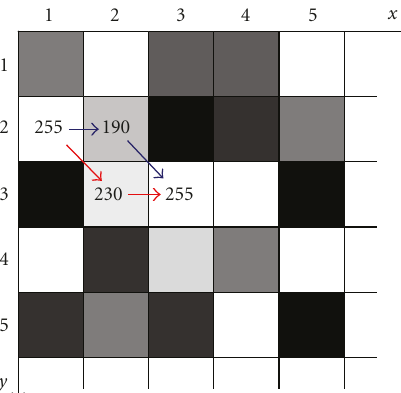
Figure 3: Di ff erent paths from p 12 to p 33 . The red path has larger PCV than the blue one does. Numbers in the figure denote the intensity